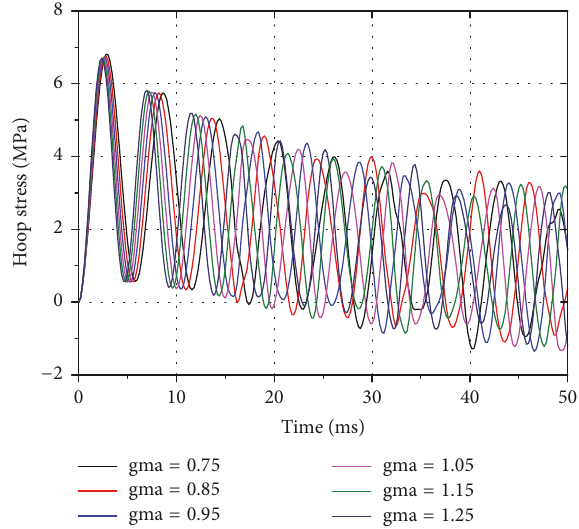
Figure 5: The influence of anisotropy on hoop stress of centre